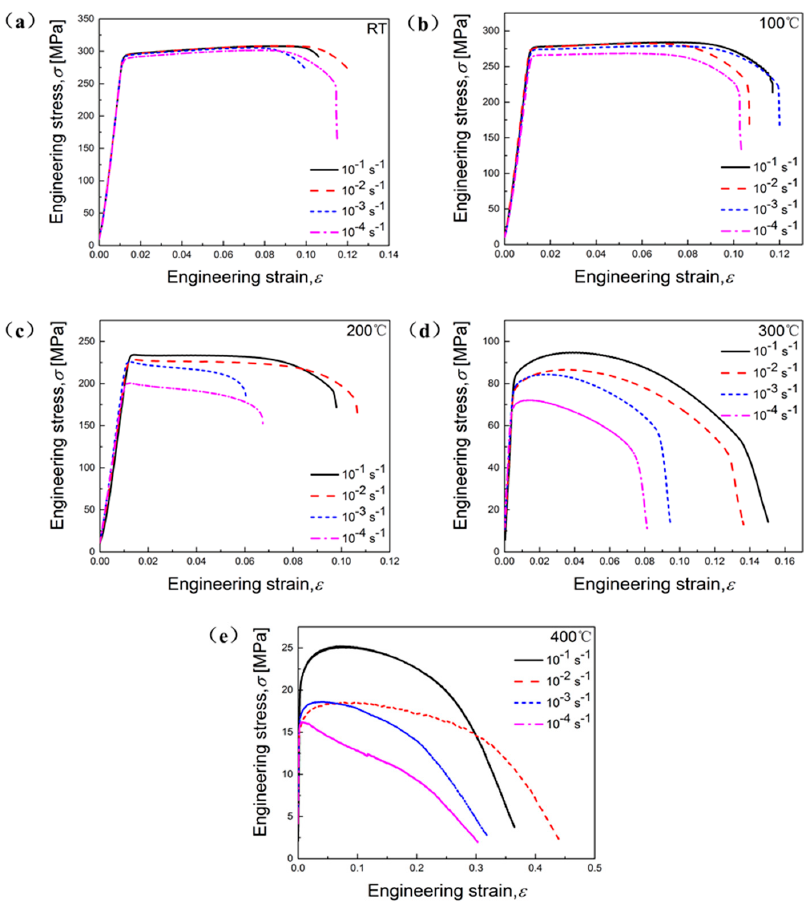
Figure 3. Engineering stress versus strain curves of the studied Al-Zn-Mg-Cu alloy for tension at various temperatures :( a ) RT; ( b ) 100 °C; ( c ) 200 °C; ( d ) 300 °C; ( e ) 400 °C.